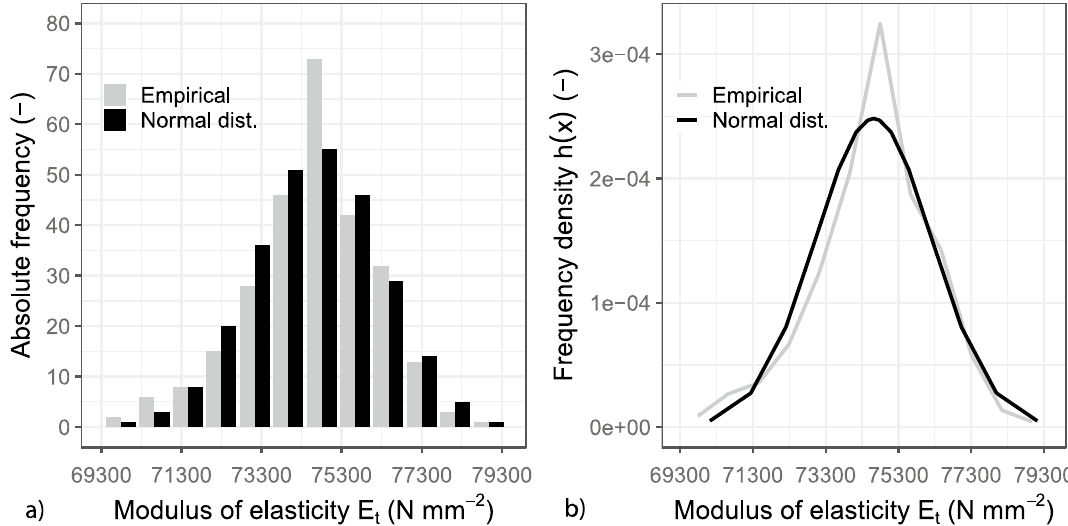
Figure 6. Statistical evaluation of the modulus of elasticity ( a ) Histogram for the AR-Glass reinforcement (observed values and expected values). ( b ) Probability density function of the AR- Glass